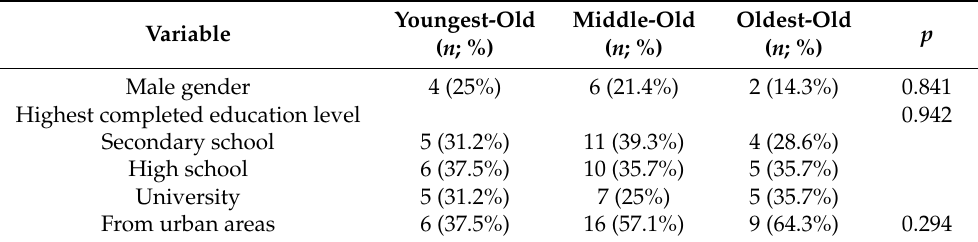
Table 1. Sociodemographic data according to different age